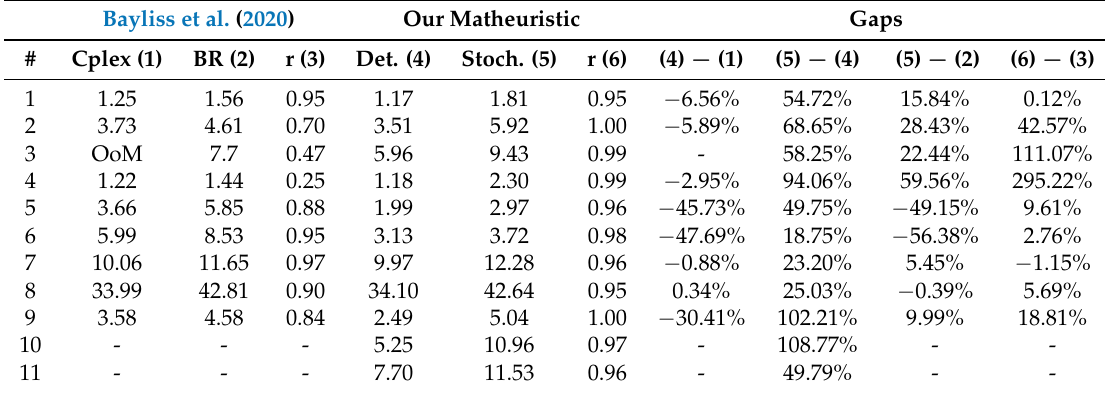
Table 2. Results obtained for each instance.